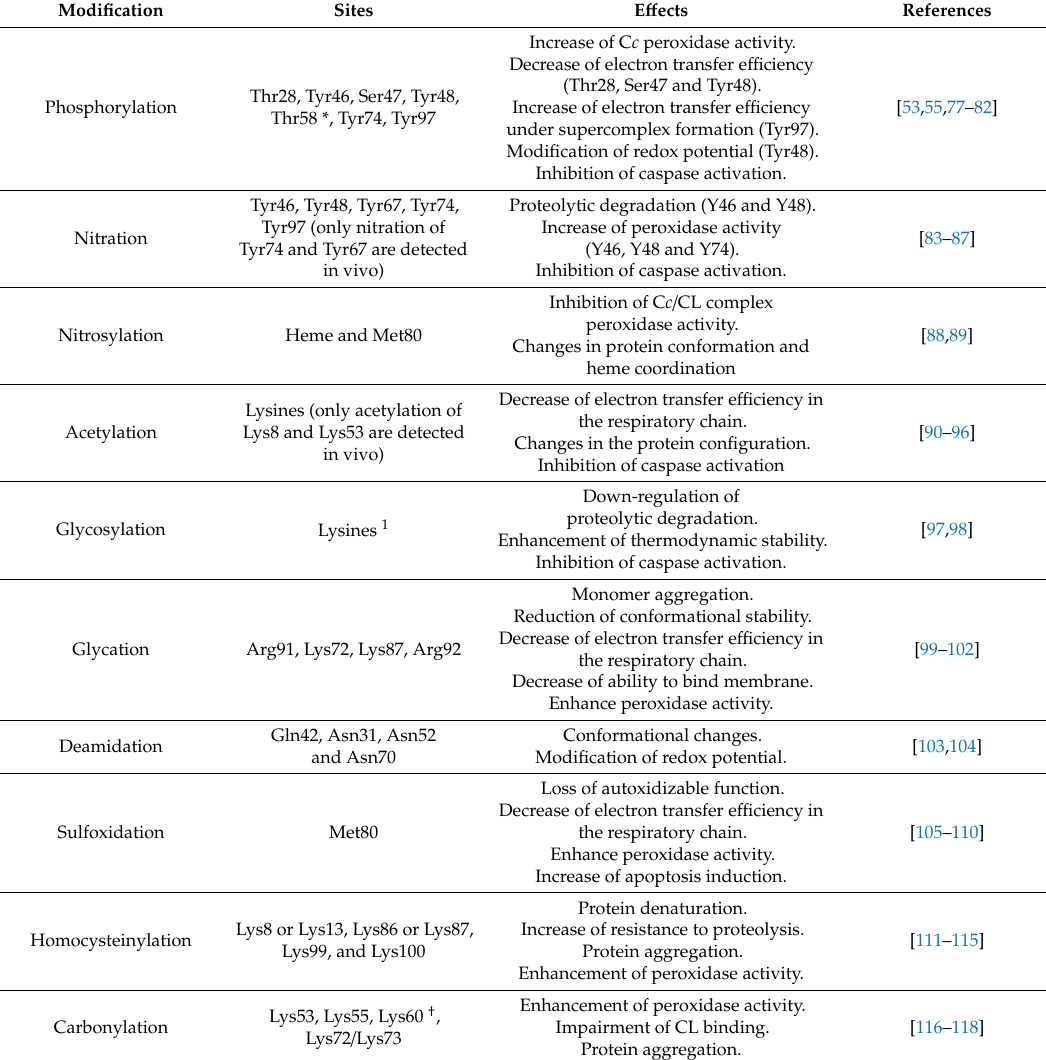
Table 1. Post-translational modifications of cytochrome c reported in the